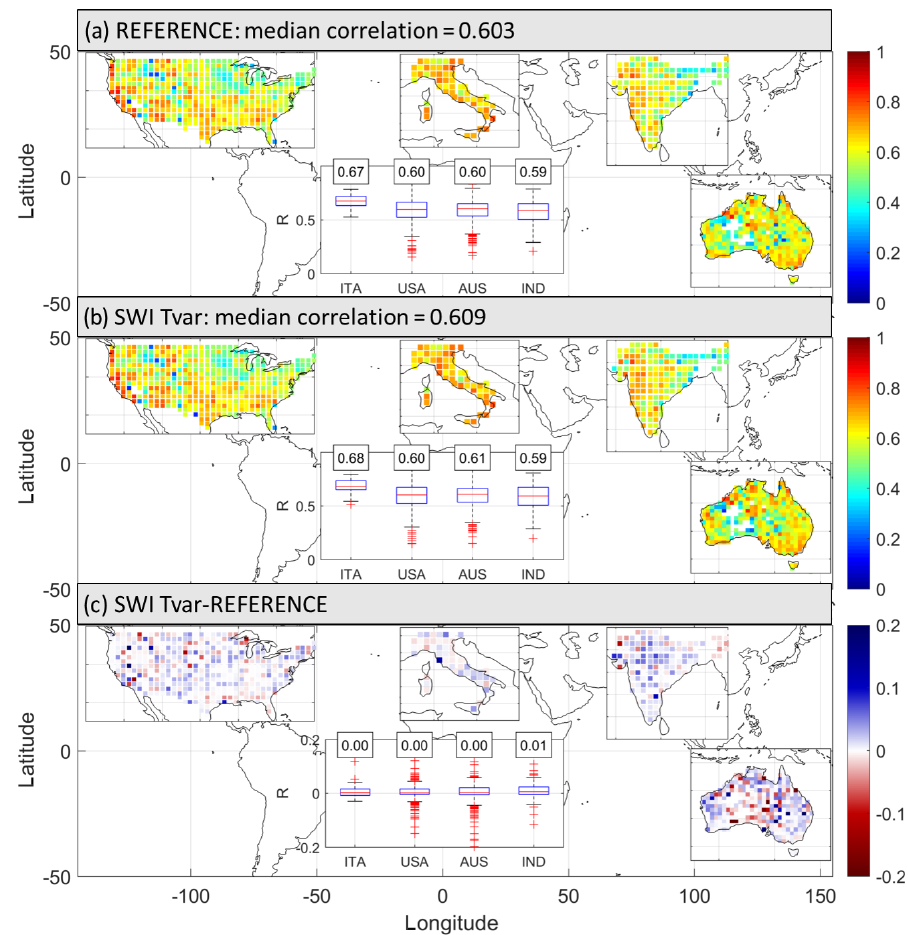
Figure 2. Performance of two different configurations at 1009 points in terms of Pearson’s correlation, R (–). (a) R map with reference configuration, (b) R map with soil water index (SWI) filtering with the variable T as a function of soil moisture, and (c) R map difference (b–a) . The inner box plots show the R values (and R differences) split for different